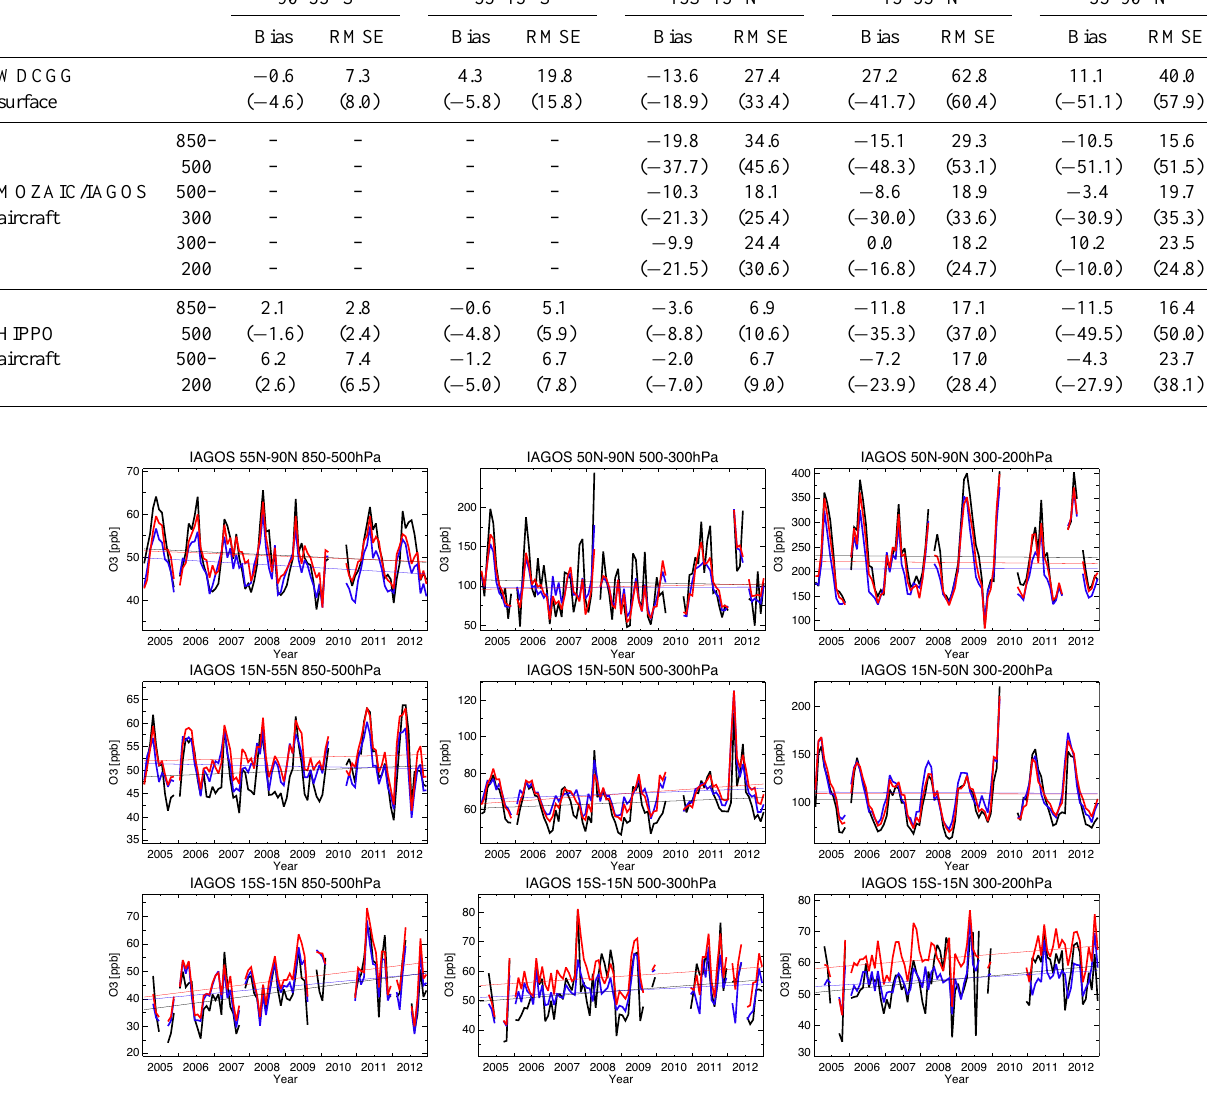
Figure 8. Time series of the monthly mean O 3 concentration obtained from the MOZAIC/IAGOS aircraft measurements (black), control run (blue), and reanalysis (red) averaged between 850 and 500hPa (left column), 500 and 300hPa (centre column), and 300 and 200hPa (right column). From top to bottom the results are shown for the NH high latitudes (55–90 ◦ N), NH mid-latitudes (15–55 ◦ N), and tropics (15 ◦ S–15 ◦